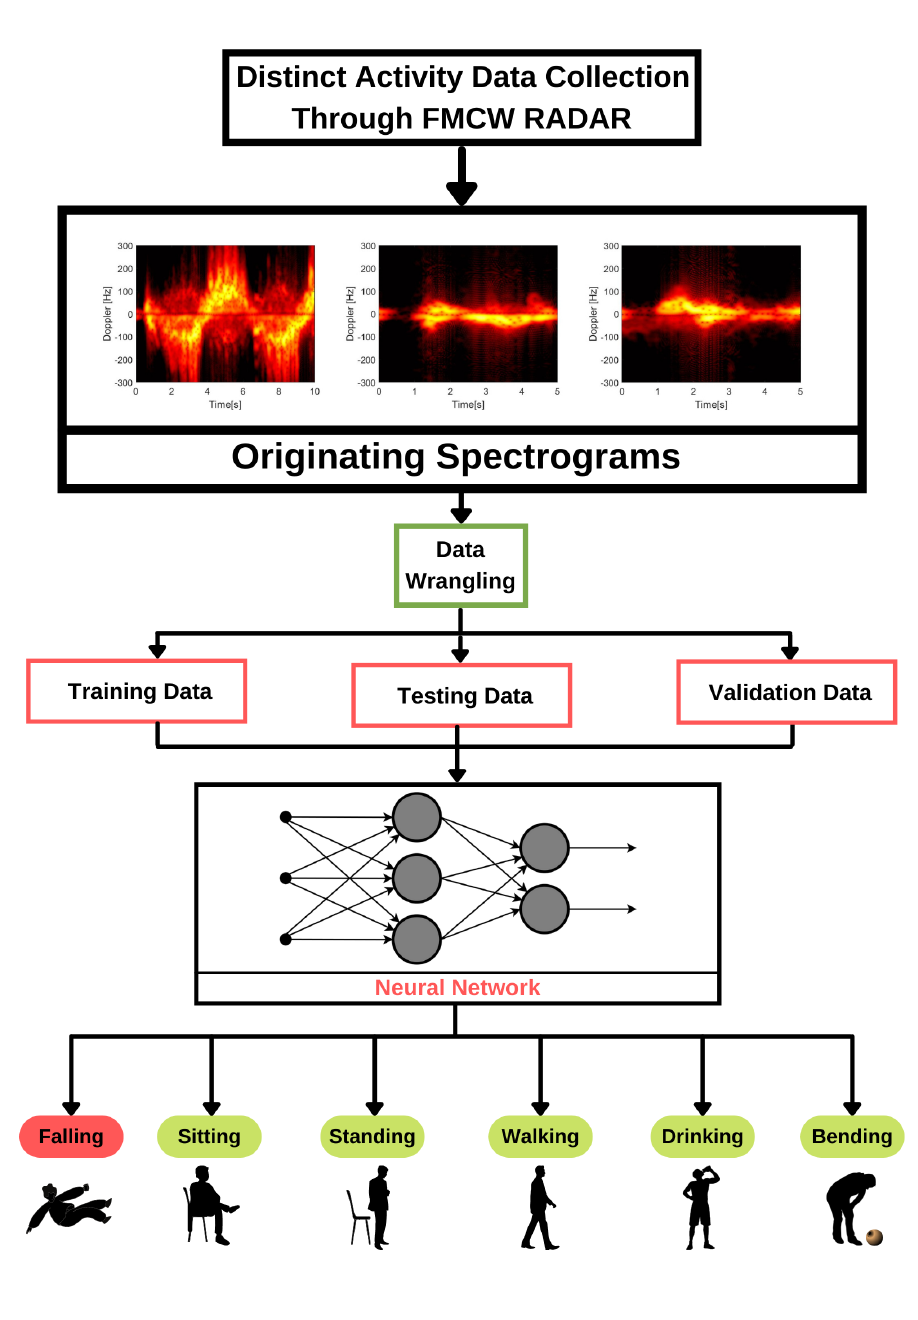
Figure 1. Framework of the proposed contactless system model for fall